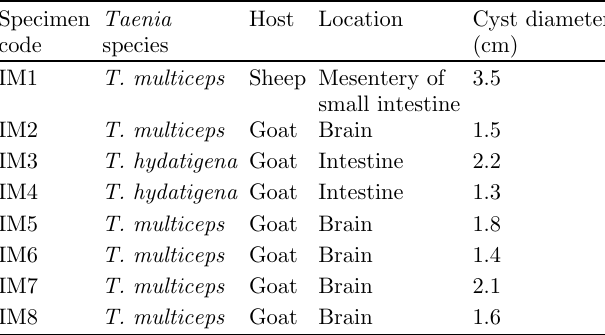
Table 1. Specimen code, location and sizeas well as host sources of metacestode